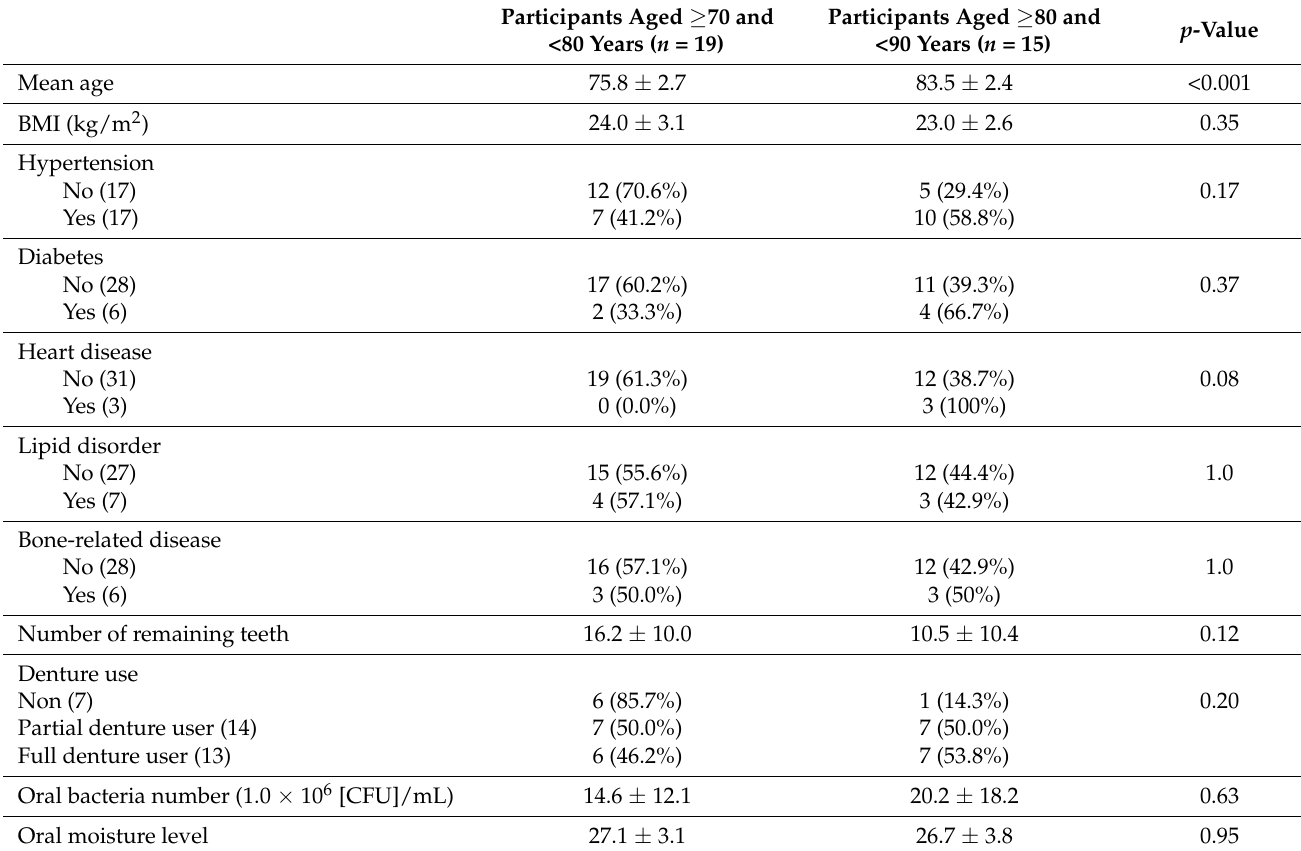
Table 1. Clinical characteristics of